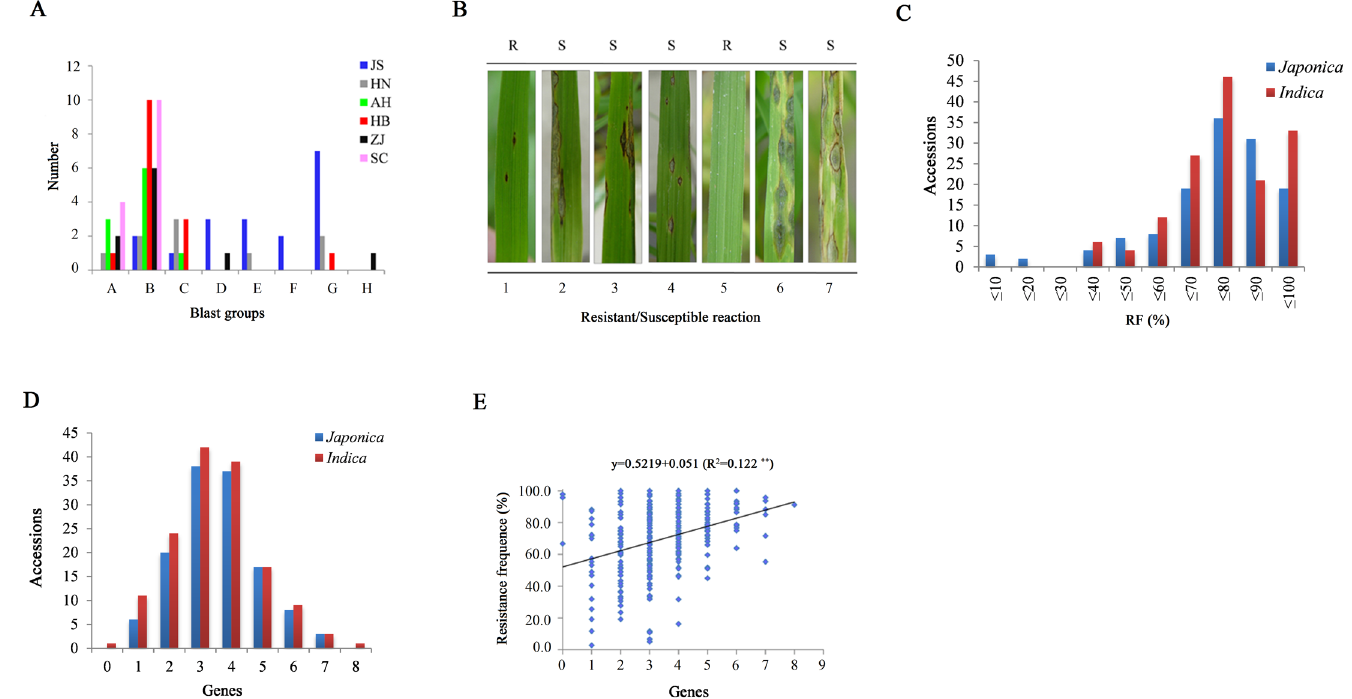
Fig 2. The disease reaction patterns in relation to the M . oryzae and 18 R genes detection in 277 rice accessions. A. The distribution of isolates in 6 typical provinces. B. The disease reactions of a typical blast isolate to 7 Chinese differential rice cultivars, 1 – 7 represent Tetep, Zhenlong 13, Sifeng 43, Dongnong 363, Kano51, Hejiang 18 and LTH, respectively. C. The distribution of RF values among accessions tested. D. The number of R genes present in 277 rice accessions. E. The relationship between the number of R genes and RF values.